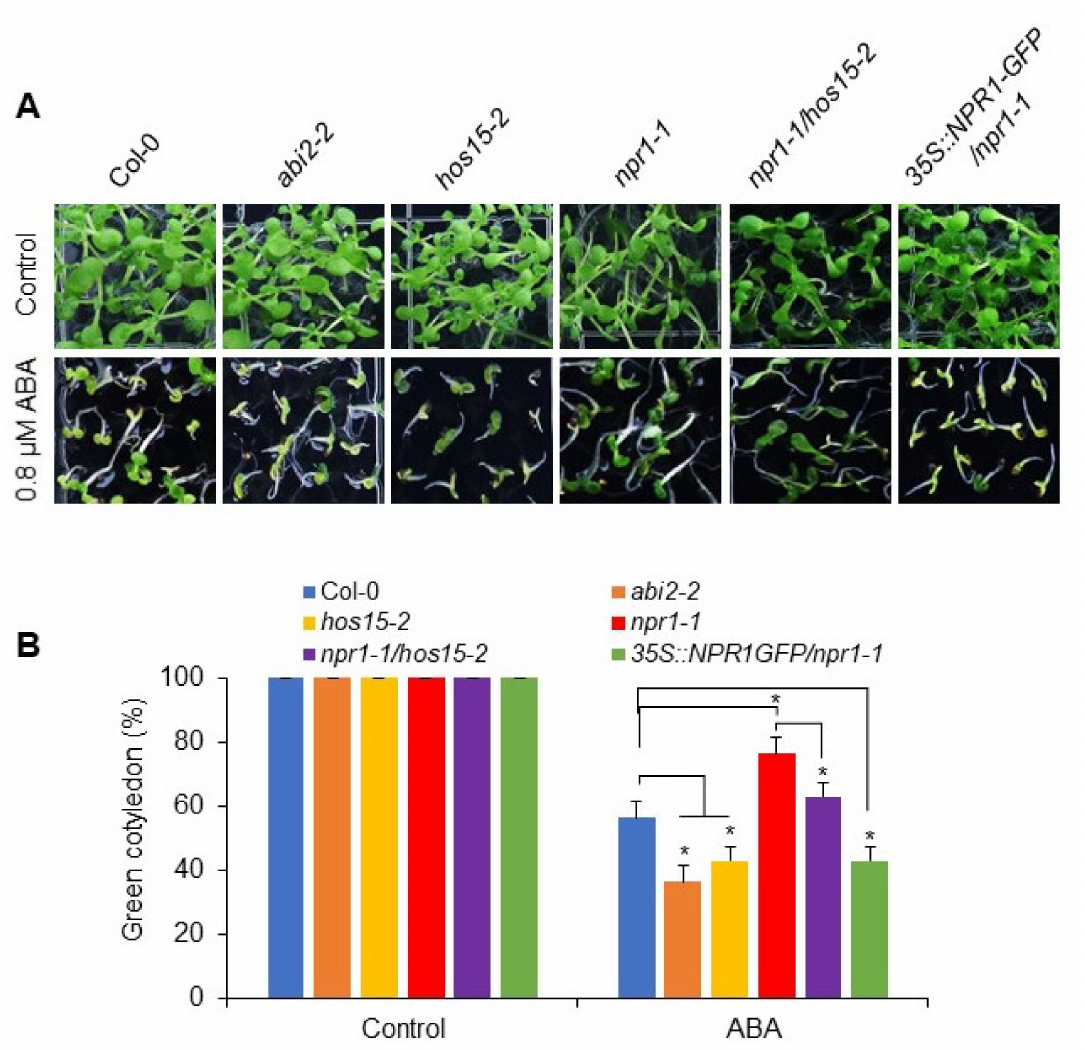
Figure 4. npr1-1 mutation is epistatic to hos15-2 . ( A ) npr1-1 mutation suppresses the ABA sensitive phenotype of hos15-2 . Seeds of Col-0, abi2-2 , hos15-2 , npr1-1 , npr1-1/hos15-2 double mutant, and 35S::NPR1-GFP/ npr1-1 strains were germinated on 1/2 MS medium with the indicated supplement of ABA. Photographs were acquired 2 weeks after germination. ( B ) The green cotyledons in ( A ) were counted 2 weeks later, with error bars representing the SE (n = 3 independent experiments